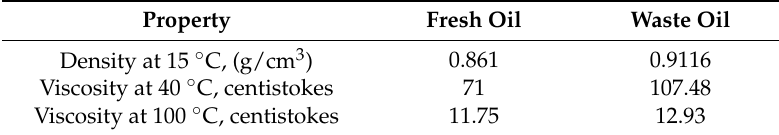
Table 2. Physical properties of fresh and waste engine oil (SAE 5W30) [29,30].